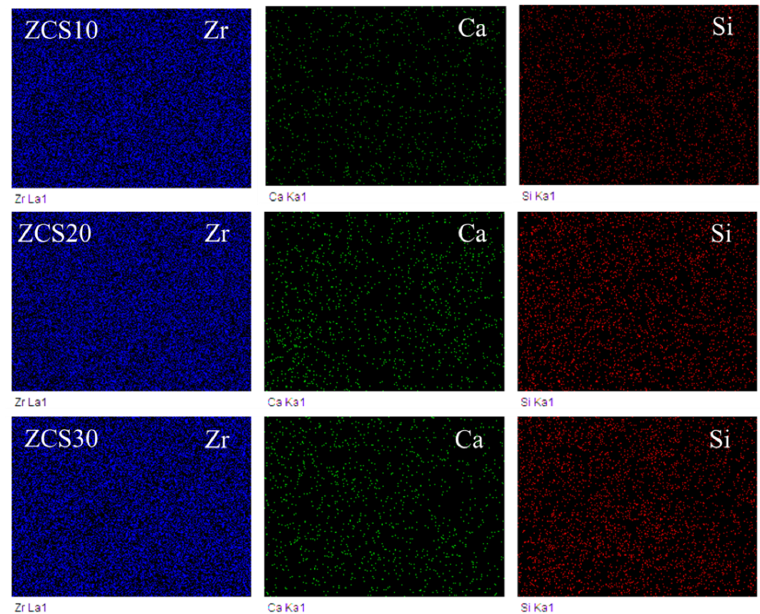
Figure 3. Zr, Ca and Si element mappings of CaSi-containing core specimen